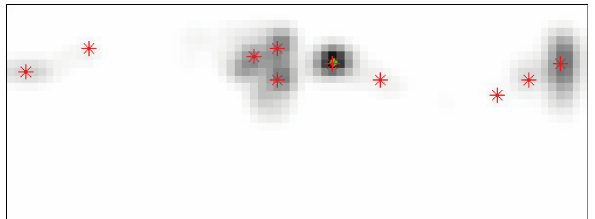
Figure 2: Example of a smoothed 2D histogram of all possible solutions with the ten detected local maxima (red) and the true solution from the ground truth (green). Abscissa: 3D rotation angle; ordinate: 3D